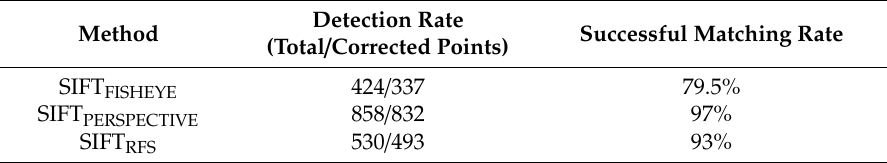
Table 2. Summarized results of SIFT for data set